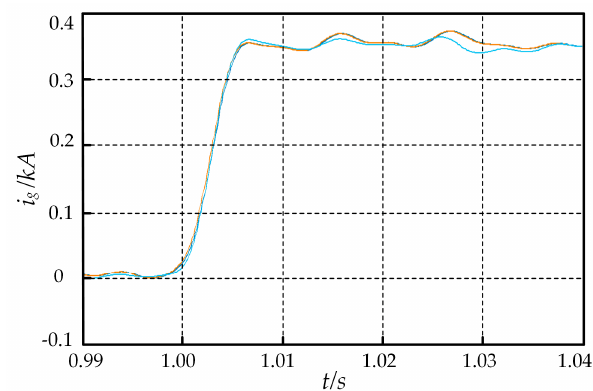
Figure 10. i g in four stations when positive pole-to-ground fault.